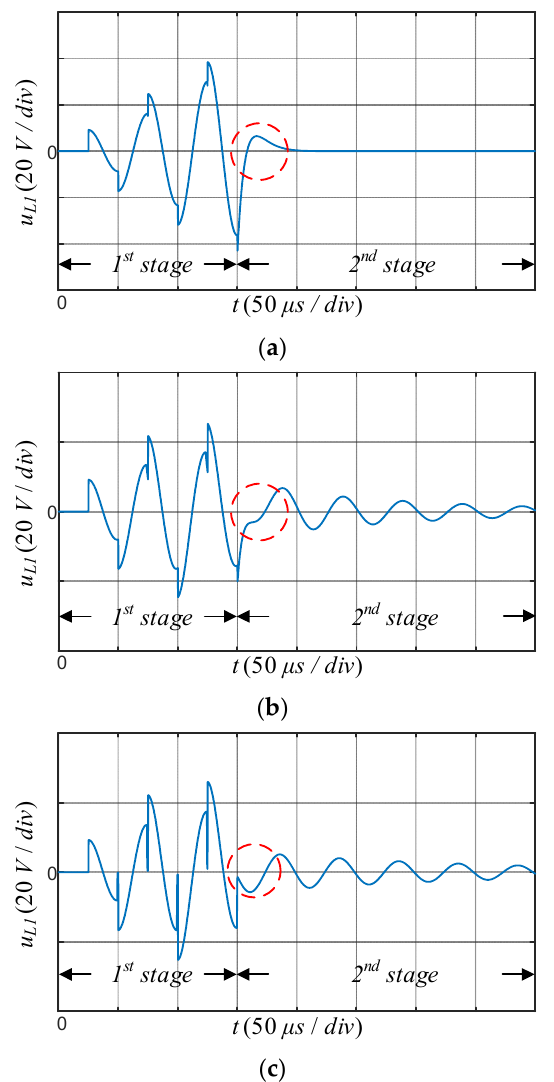
Figure 5. Simulation waveforms of primary side inductor voltage u L 1 under different suppression resistance R d and the mutual inductance M. ( a ) R d = 15 Ω and M = 0. ( b ) R d = 15 Ω and M = 10 μ H. ( c ) R d = 1000 Ω and M = 10 μ H. Table 1. Simulation parameters.